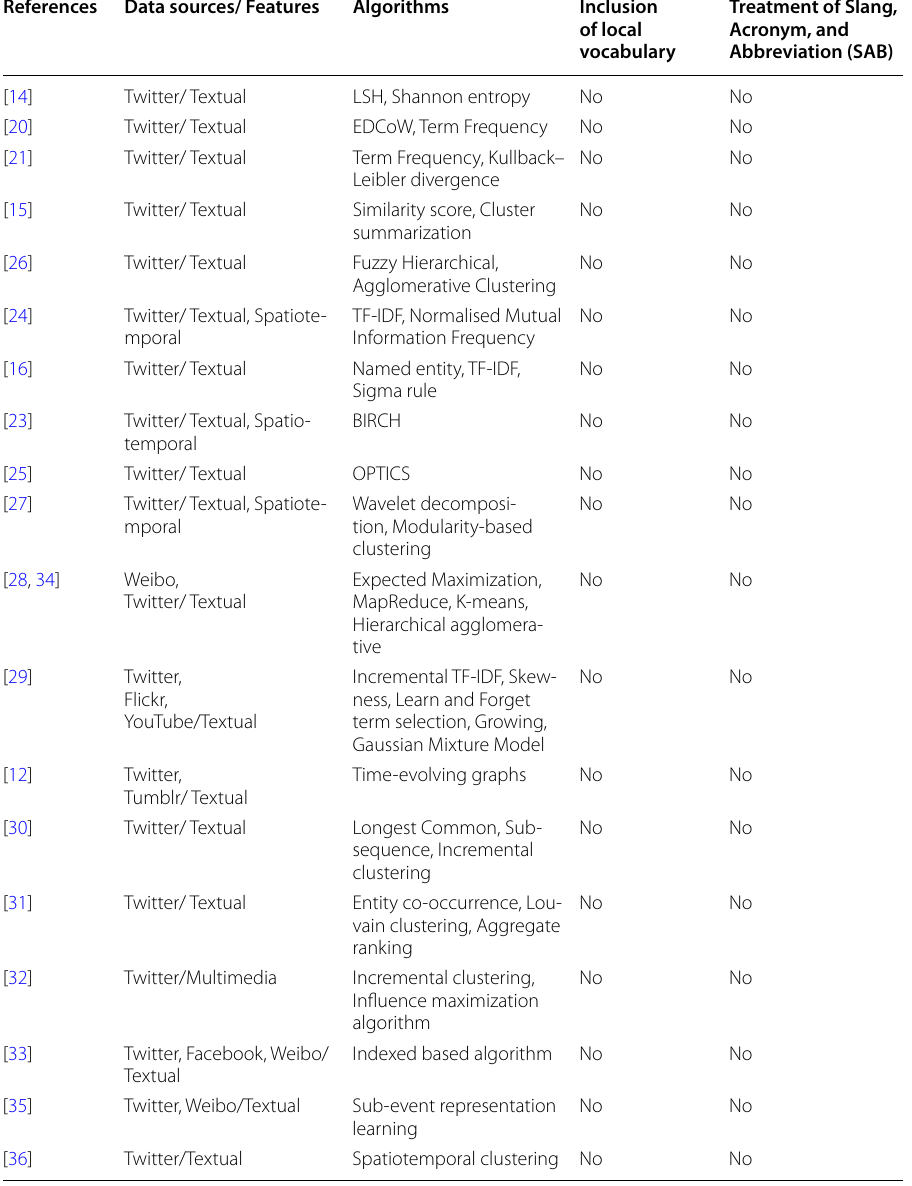
Table 1 Unsupervised learning approaches used for event detection